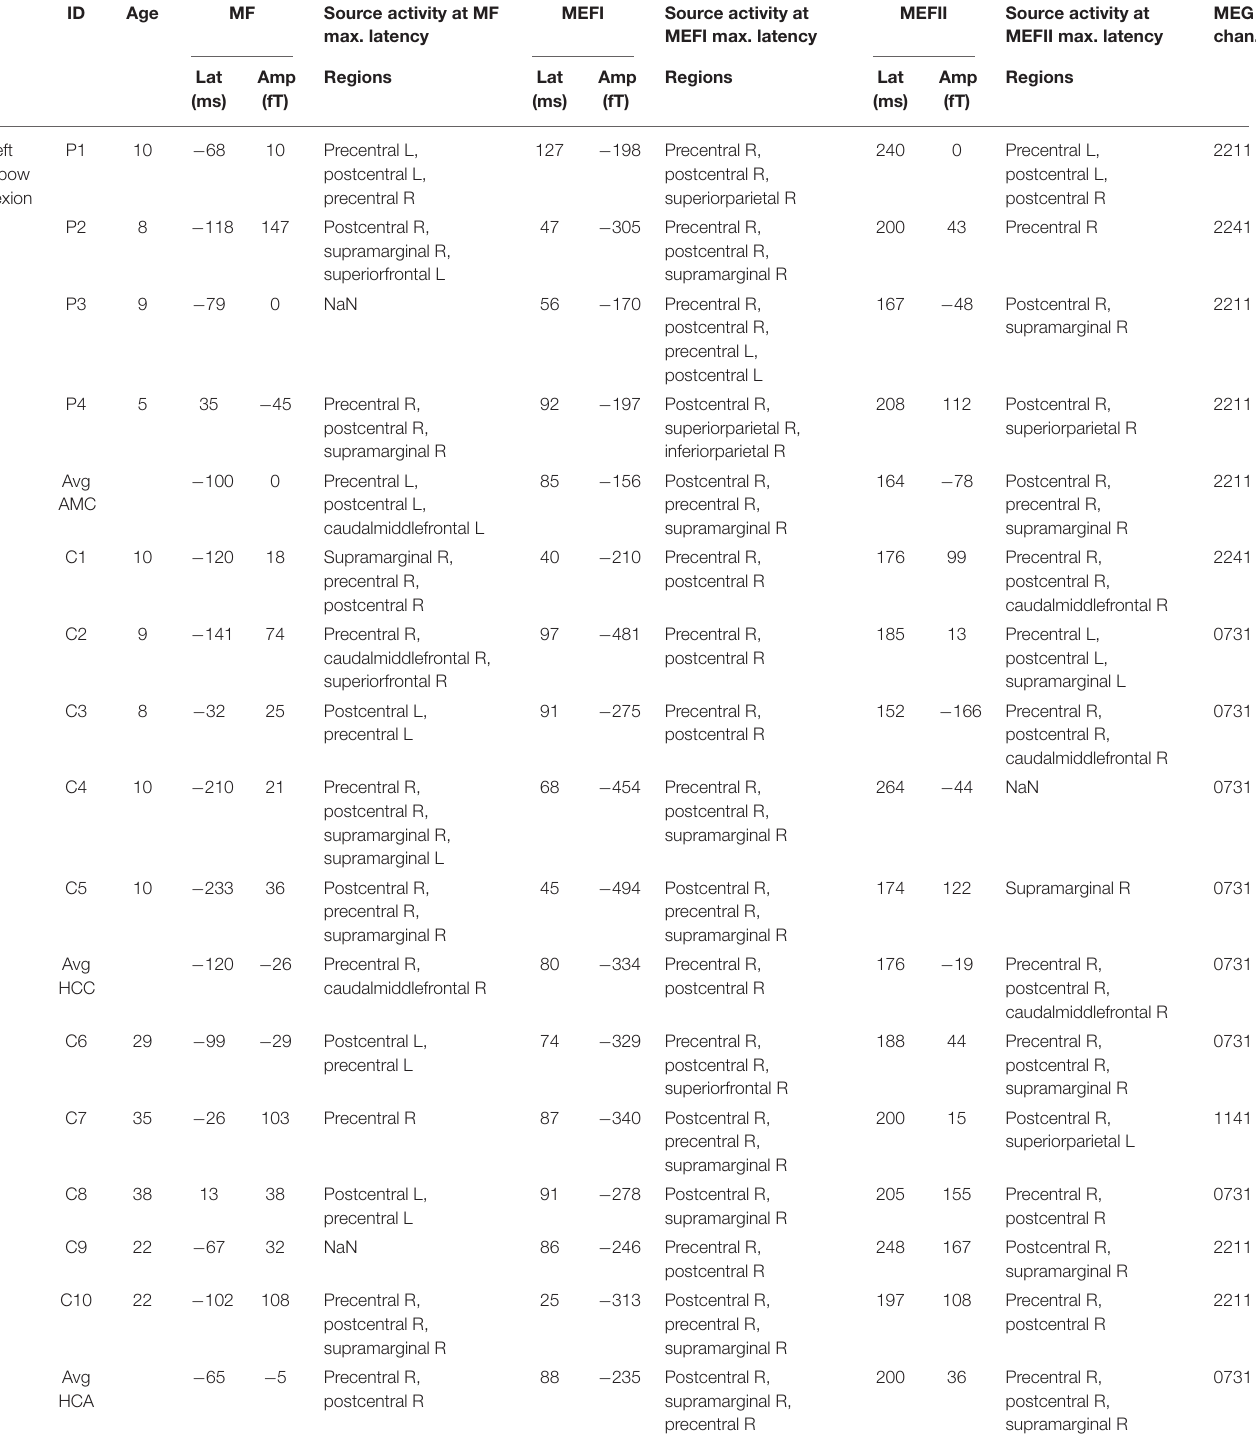
TABLE 2 | Descriptive information about individual subject and group averaged brain 800 responses associated with the semi-voluntary elbow flexion task performance: latencies (Lat) (ms); peak amplitudes (Amp) (fT), of MF, MEFI, and MEFII responses measured at the representative channel (MEG chan.); names of the brain regions associated with underlying source activities. Groups: AMC, AMC patients; HCC, healthy control children; HCA, healthy control